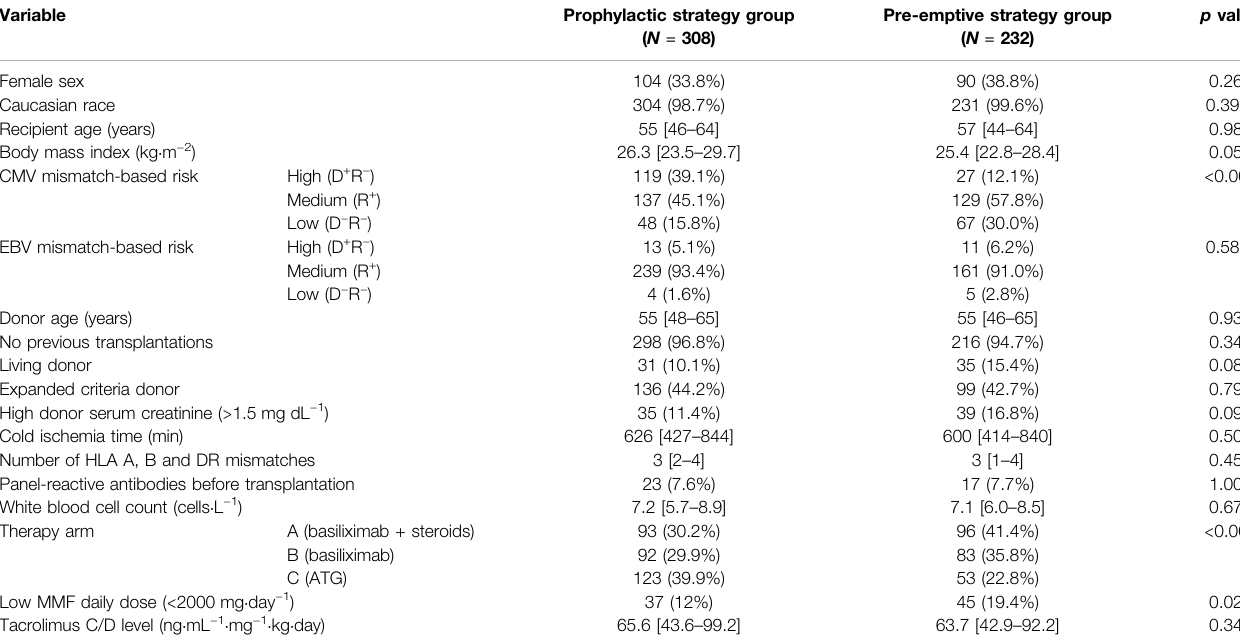
TABLE 1 | Differences in patient baseline characteristics between strategy groups.